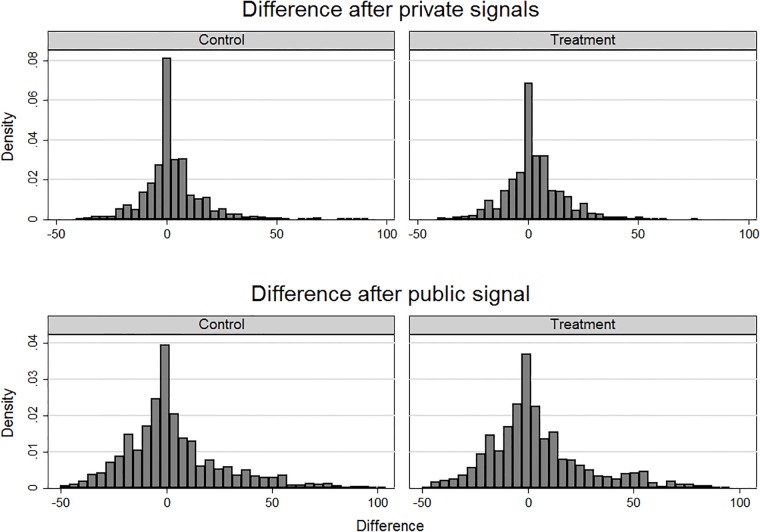
Histogram of variable Difference, by the type of signal and treatment status.